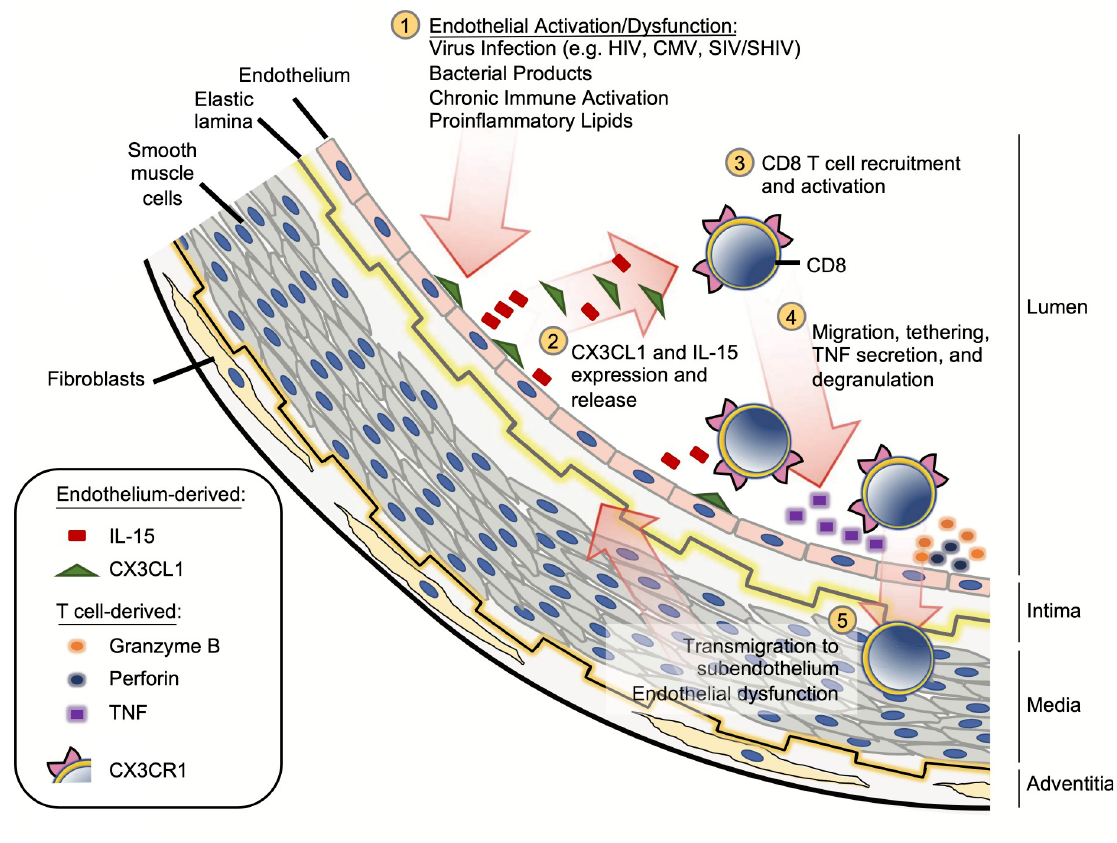
Fig 7. Model linking CX3CR1+ CD8 T cells, TNF, and IL-15 to endothelial dysfunction and vascular inflammation. (1) Endothelial cell activation/dysfunction is induced by viral infection, bacterial products, and/or proinflammatory cytokines and lipids; (2) Activated endothelial cells express and release CX3CL1 and IL-15; (3) IL-15 activates CD8 T cells by arming them with the cytolytic molecules, promoting CX3CR1 expression, and increasing TNF production; (4) CX3CL1/CX3CR1 interactions promote CD8 T cell migration and tethering to the activated endothelium, where the cells release TNF and lytic granules like granzyme B and perforin; (5) TNF and endothelial damage further increase CX3CL1 and bioactive IL-15 expression by vascular endothelial cells creating a positive proinflammatory feedback loop that facilitates continued endothelial cell activation, damage, and accumulation of activated CD8 T cells in the subendothelium. These changes may promote atherogenesis in HIV infection and in HIV-uninfected individuals with persistent vascular